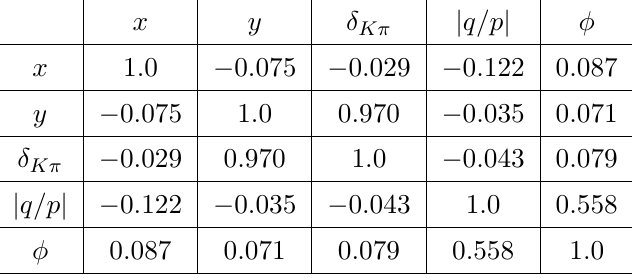
Table 2 . Correlation matrix for the needed D 0 − D 0 mixing parameters from ref.